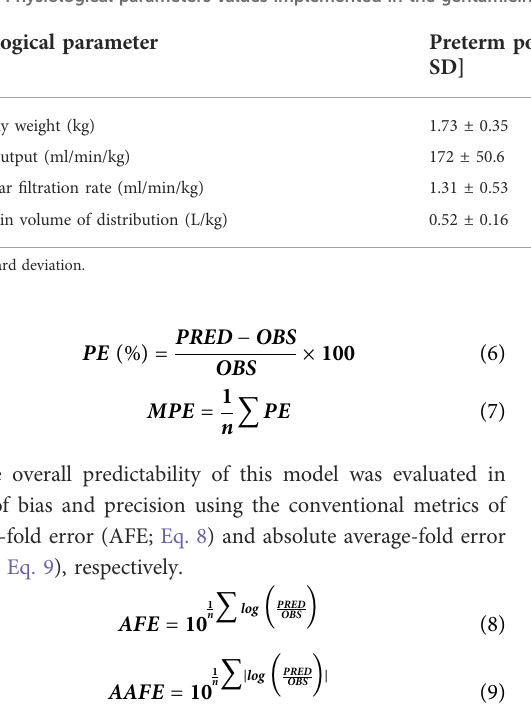
TABLE 2 Physiological parameters values implemented in the gentamicin minimal PBPK